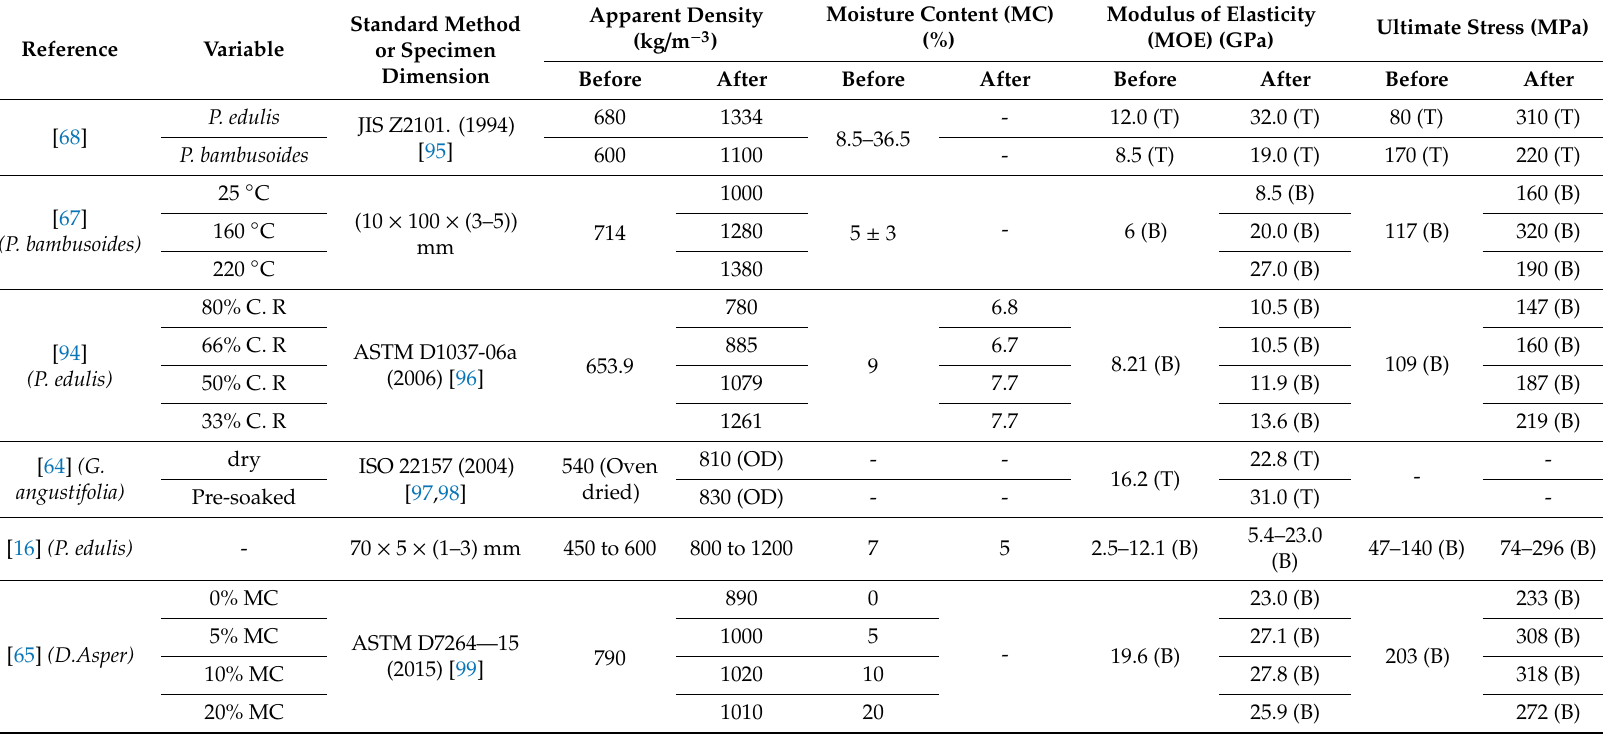
Table 3. Summary of the mechanical and physical properties of bamboo, before and after densification